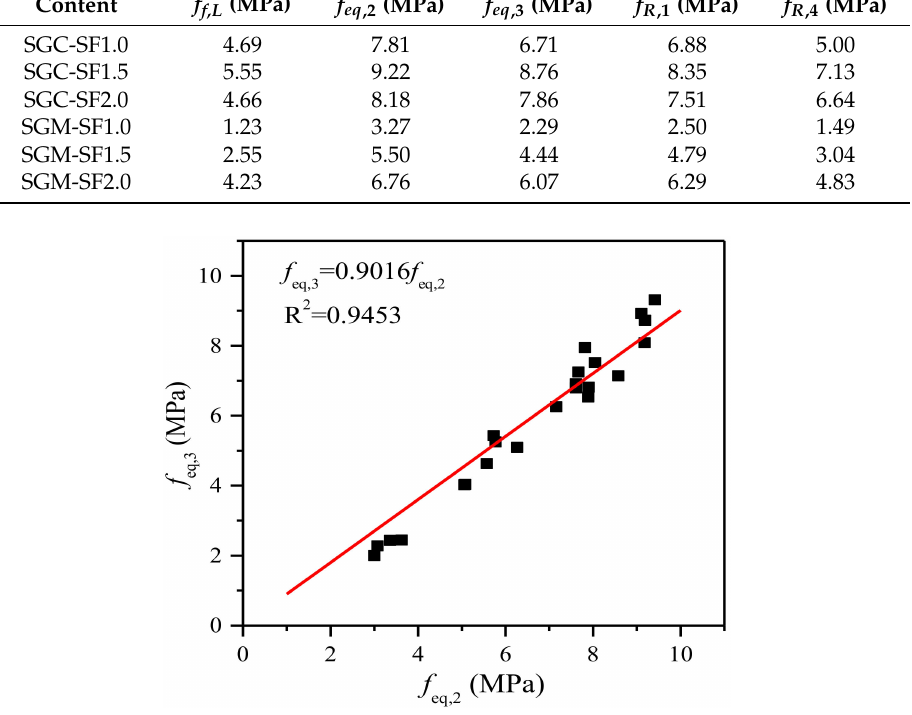
Figure 9. Relationship between f eq ,2 and f eq ,3 .